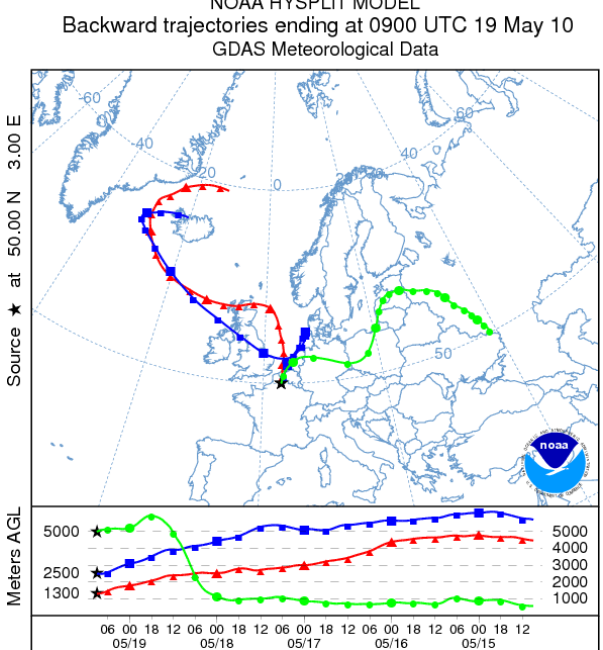
Figure 9. Air-mass back trajectories for Lille at 08:00UTC, 19 May 2010, (NOAA HYSPLIT model).